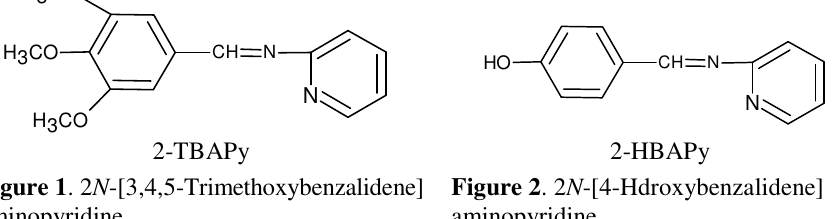
Figure 2 . 2 N -[4-Hdroxybenzalidene]